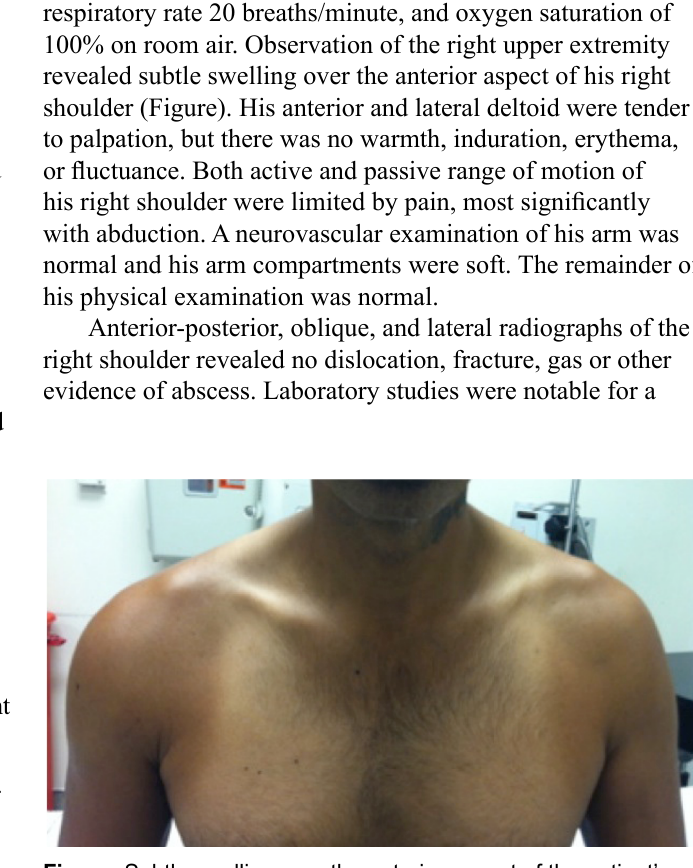
Figure. Subtle swelling over the anterior aspect of the patient’s right